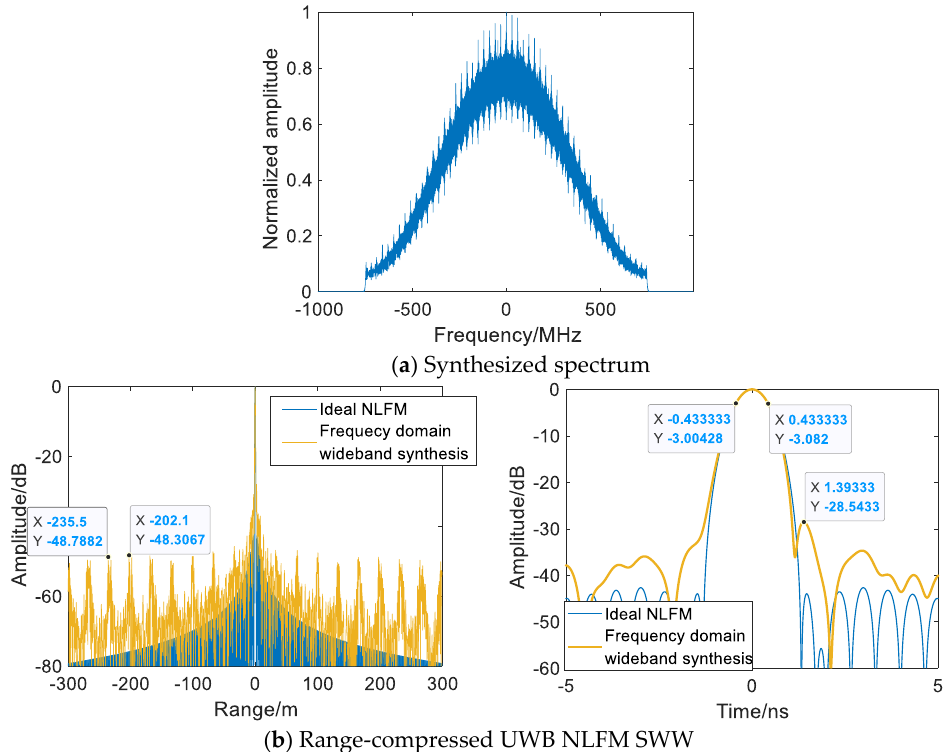
Figure 11. Frequency domain wideband synthesis method.